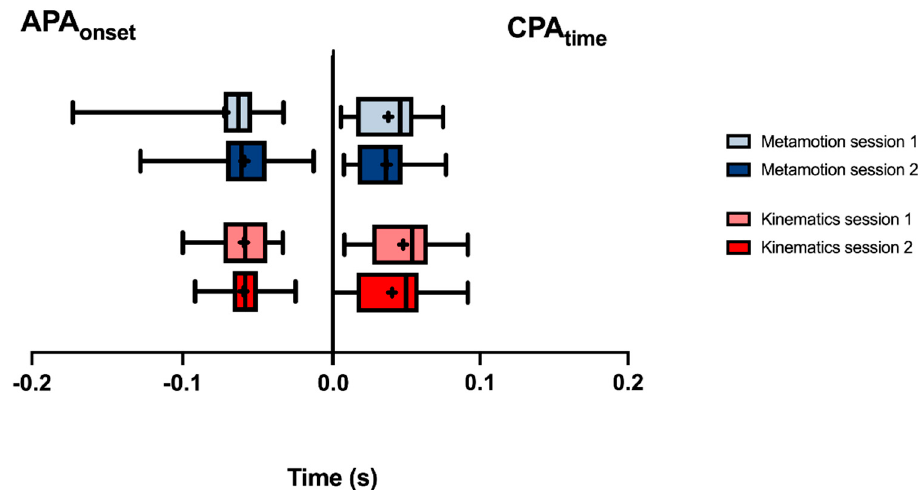
Figure 4. Descriptive analysis of means and standard deviation of anticipatory variables, measured by the video-motion-capture system and Metamotion C . Data expressed by the central line = median; box = 25th and 75th percentiles; bars = minimum and maximum values (average values within the box marked X).